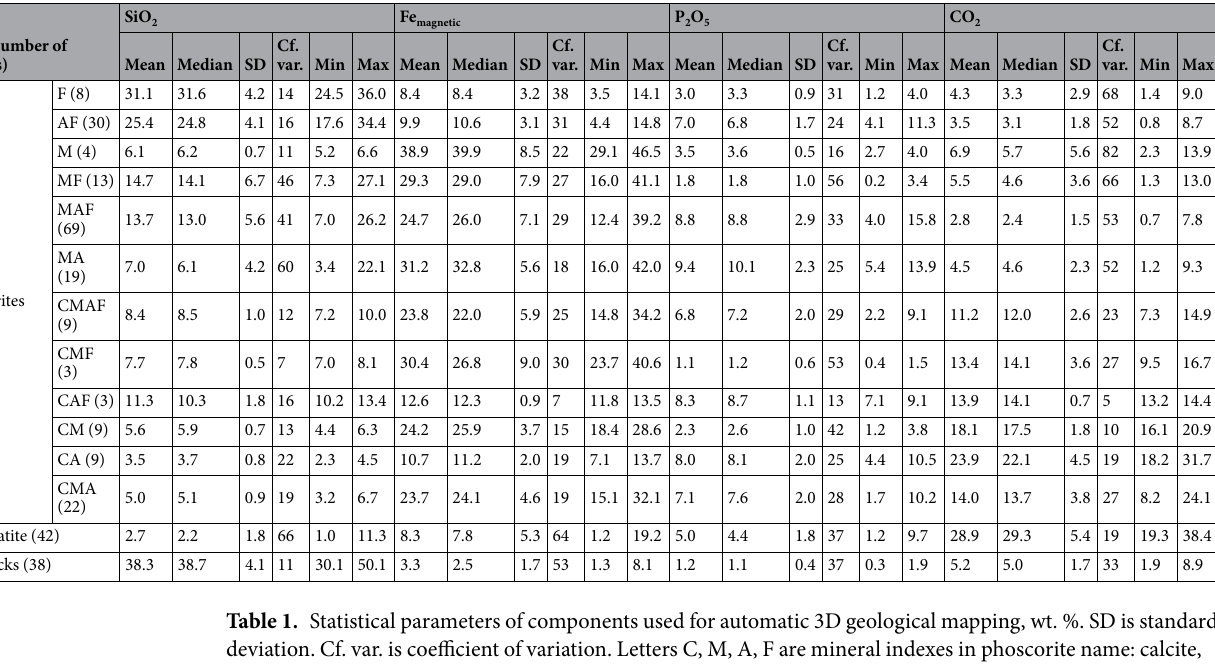
− 2bulk rock C (CO 100)/43 97; − magnbulk rock M (Fe 100)/72 40; − A (P O 100)/42 39; + F 100 (C M A);